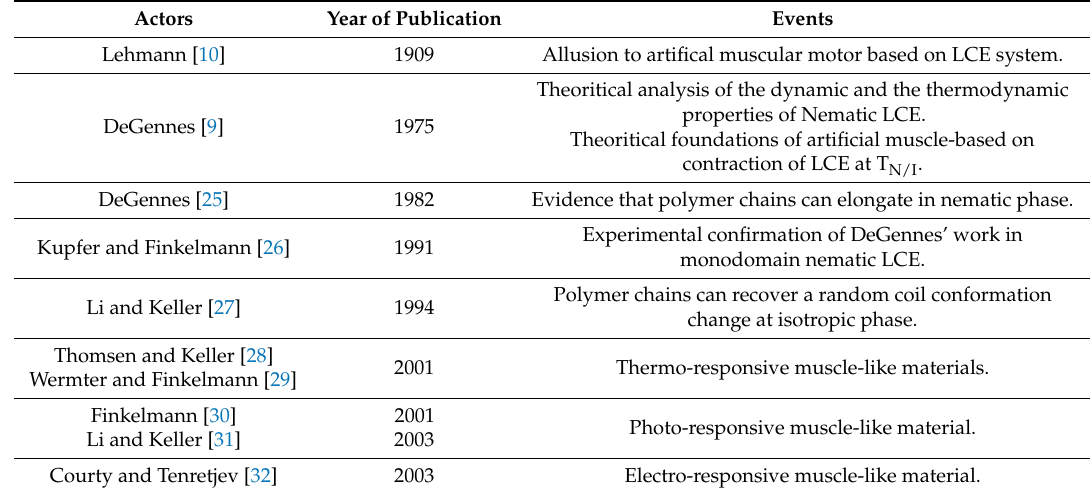
Table 1. Timeline of LCE studies leading towards biological